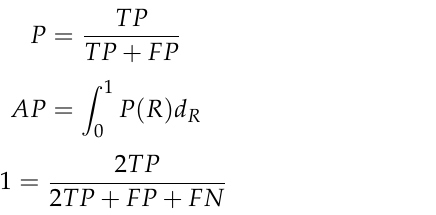
Table 2. Comparison of model performance after optimization (bar code).